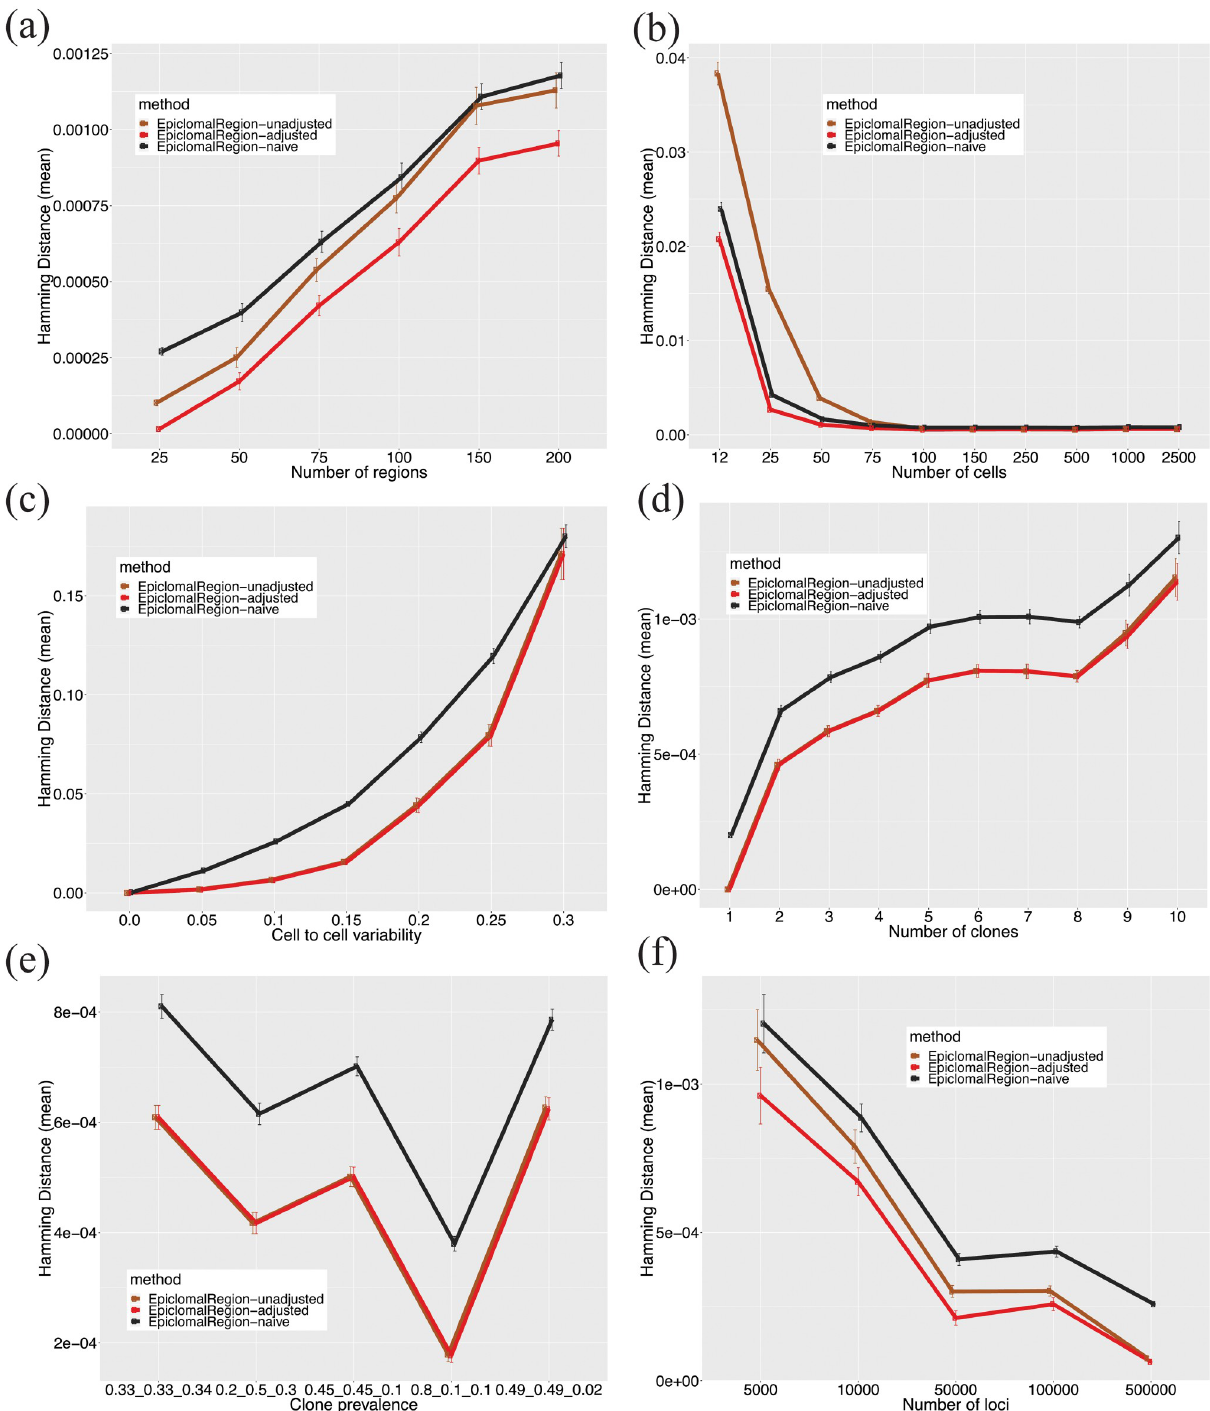
Fig 5. Imputation results on synthetic data. Average hamming distance for three variants of EpiclomalRegion inferred methylation states: unadjusted, adjusted, and naive (see Sections 1.2 and 3.4 in S1 Material) when varying: (a) the number of regions, (b) the number of cells, (c) the cell-to-cell variability, (d) the number of clones, (e) the cluster frequencies (prevalences), and (f) the number of loci. The vertical bars correspond to one standard deviation above and below the mean value.